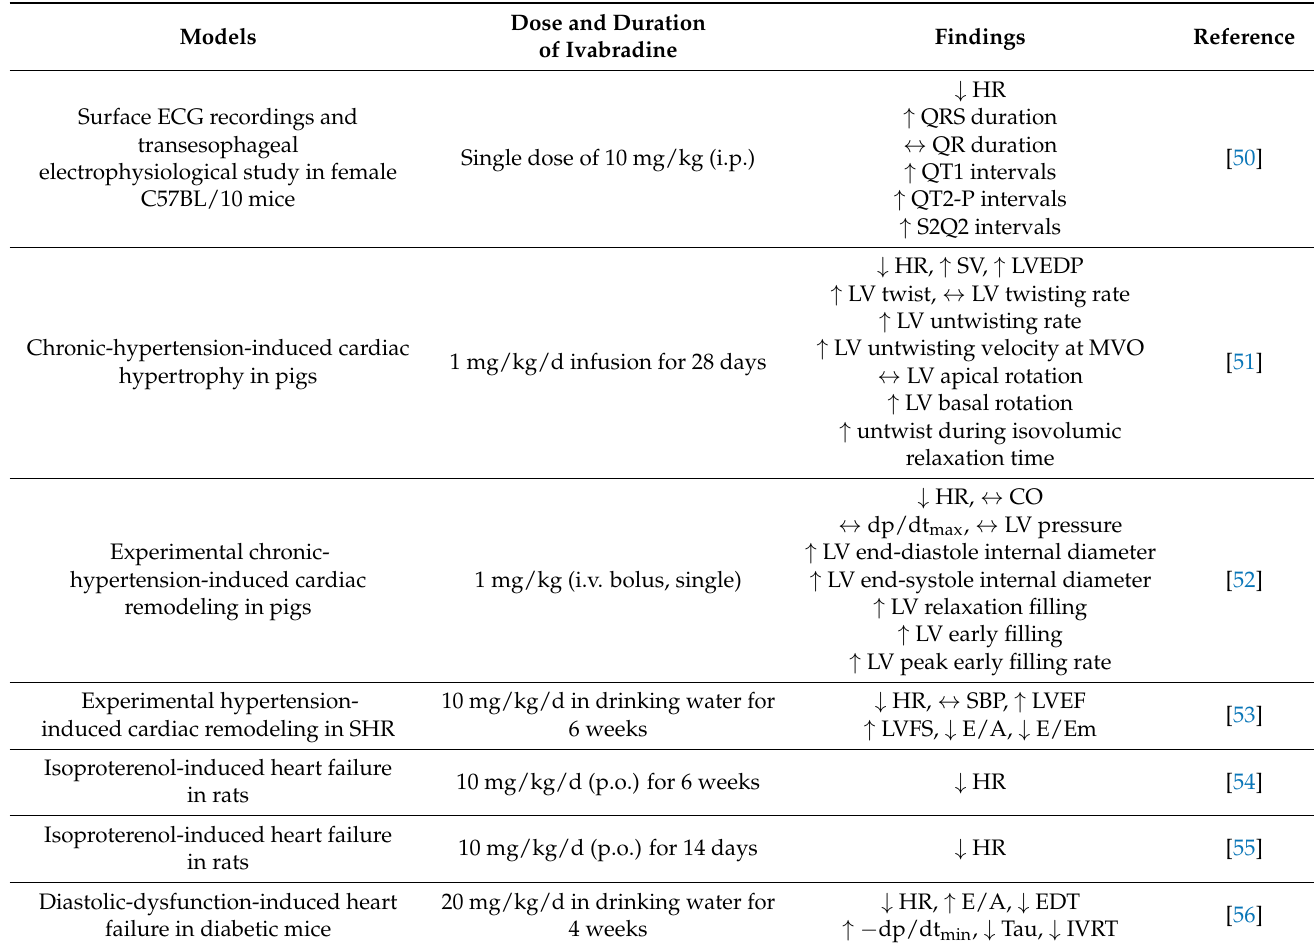
Table 3. Effects of ivabradine on cardiac function in animal